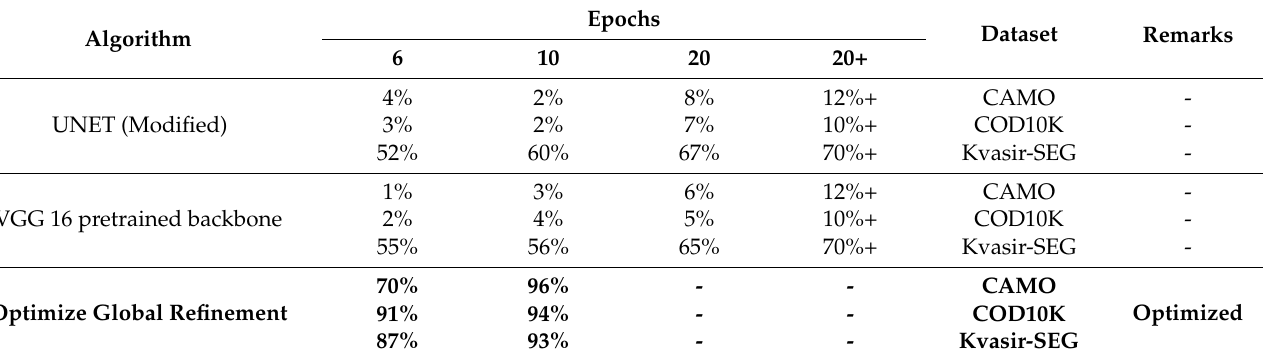
Table 1. Comparison of the proposed method with pre-trained UNet and